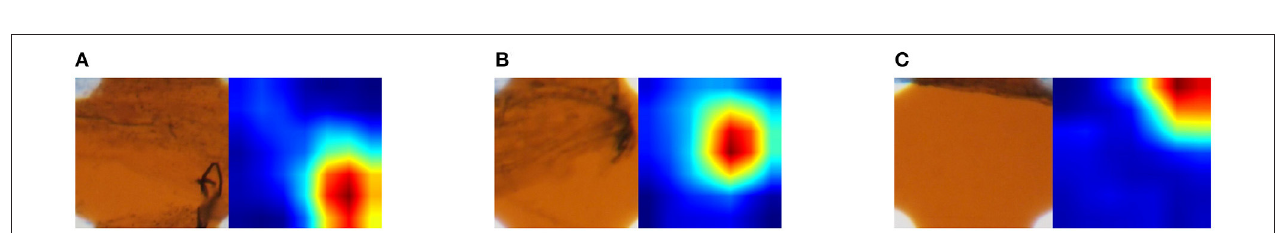
FIGURE 8 | Original sampling area (left) and importance of sampling areas indicated by CAM (right). CAM visualizes the importance for classifying images. The more red the pixel values are, the more important for classification, and the more blue, the less important. The magnification of the slide images was 40x. (A) Classified an image of class 1 correctly. (B) Misclassified an image of class 1 as class 0. (C) Misclassified an image of class 1 as class 2.